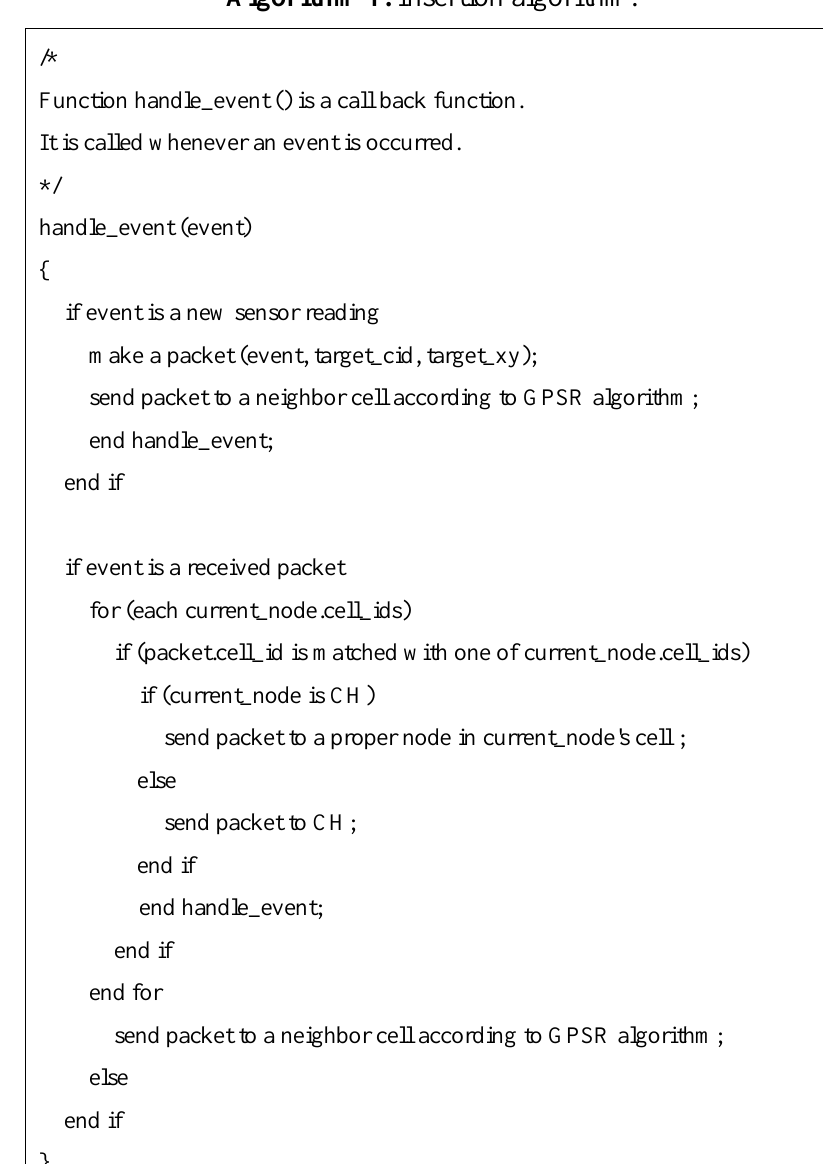
Algorithm 1. Insertion algorithm.